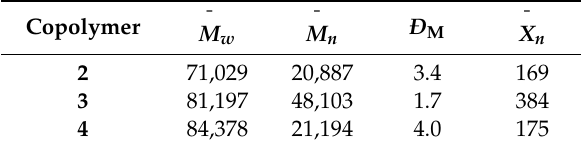
Table 1. Average molecular weights ( M w , M n ), molecular-weight dispersities ( Ð M ) and